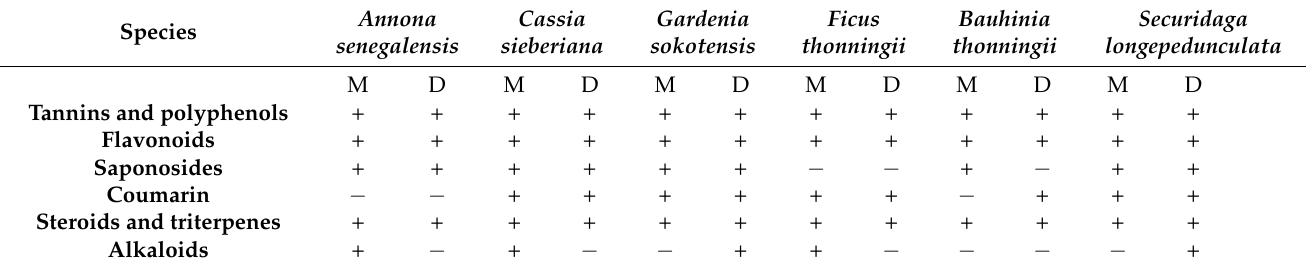
Table 3. Results of phytochemical screening of species.